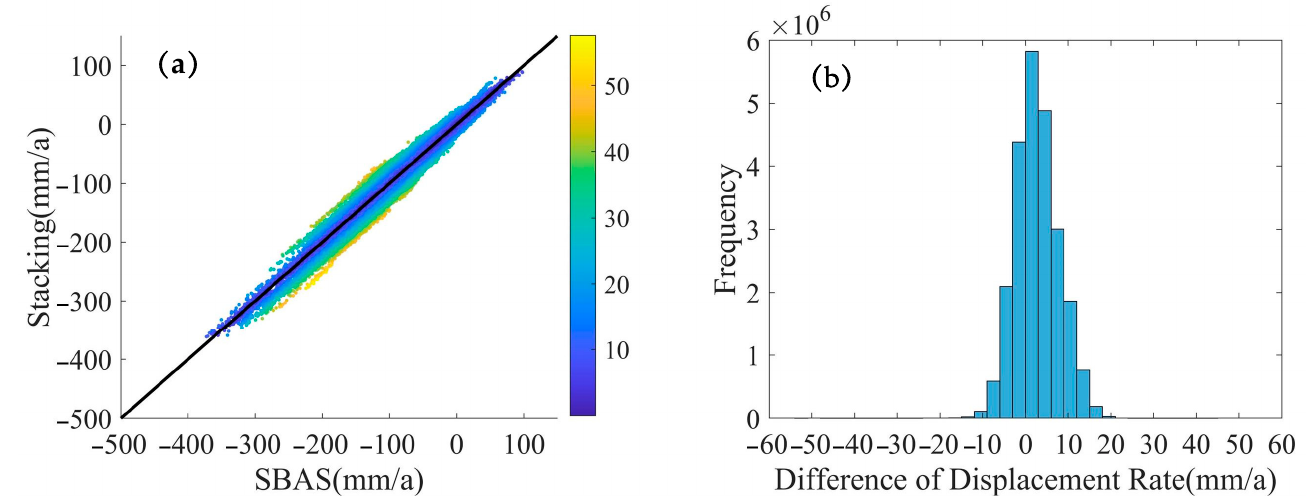
Figure 12. ( a ) Correlation of the displacement rate results acquired by stacking-InSAR and SBAS- InSAR. ( b ) The difference in displacement rate results acquired by the two methods.